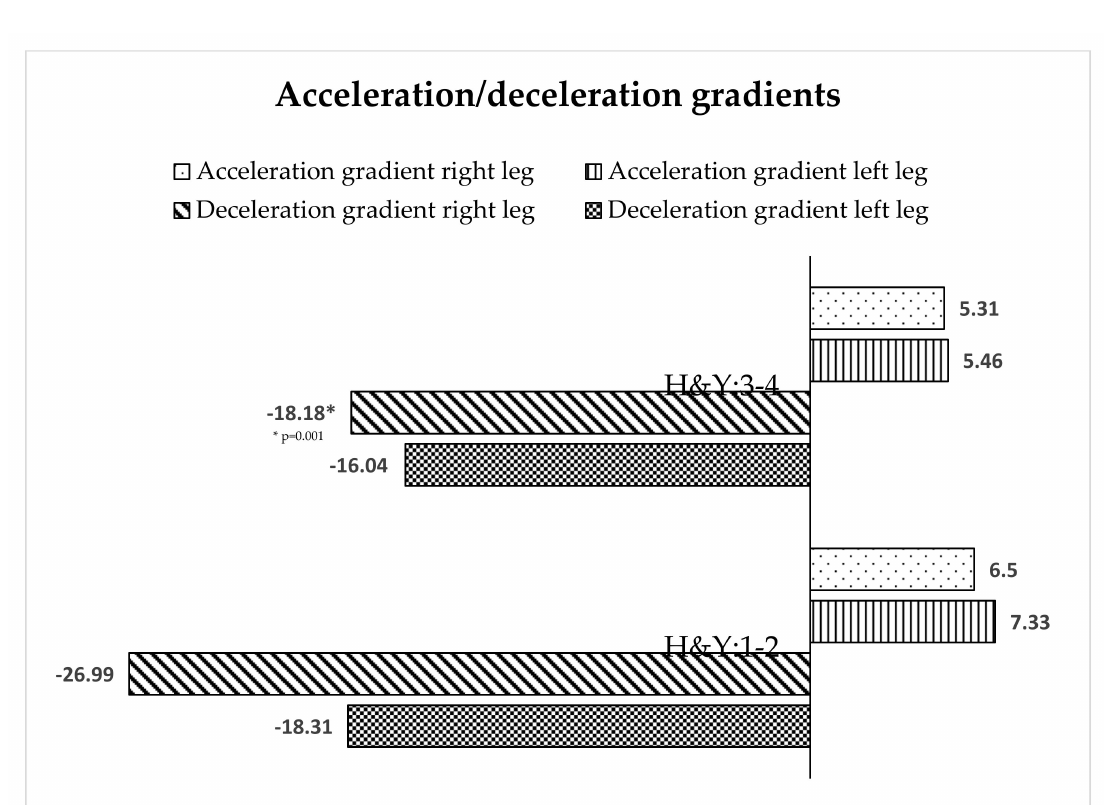
Figure 3. Acceleration/deceleration gradients of gait depending on the stage of